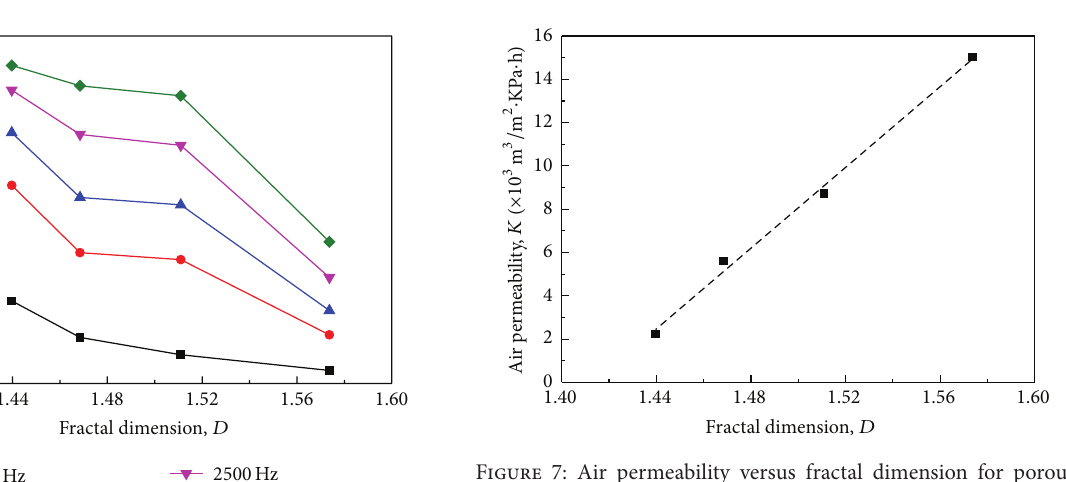
Figure 7: Air permeability versus fractal dimension for porous metal fiber materials.